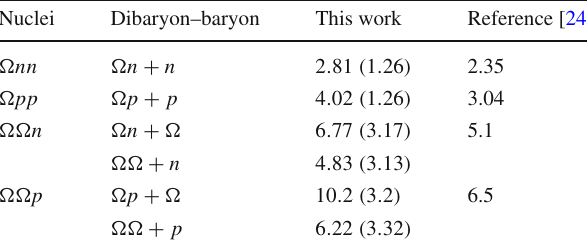
Table 4 Comparison of binding energies between folding model cal- culation (this work) and the work of Garcilazo and Valcarce (Ref. [24]). It seems that (cid:3) N N and (cid:3)(cid:3) N whose spin is smaller than 5/2 is weakly bound to the third baryon Nuclei Dibaryon–baryon This work Reference [24]